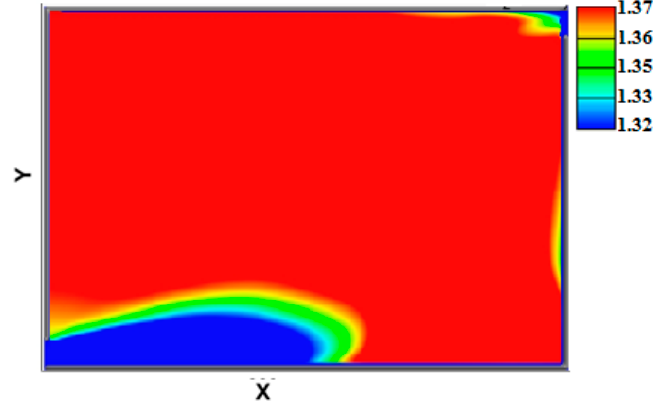
Figure 7. The pattern of sediment deposition in the G3716 reservoir.